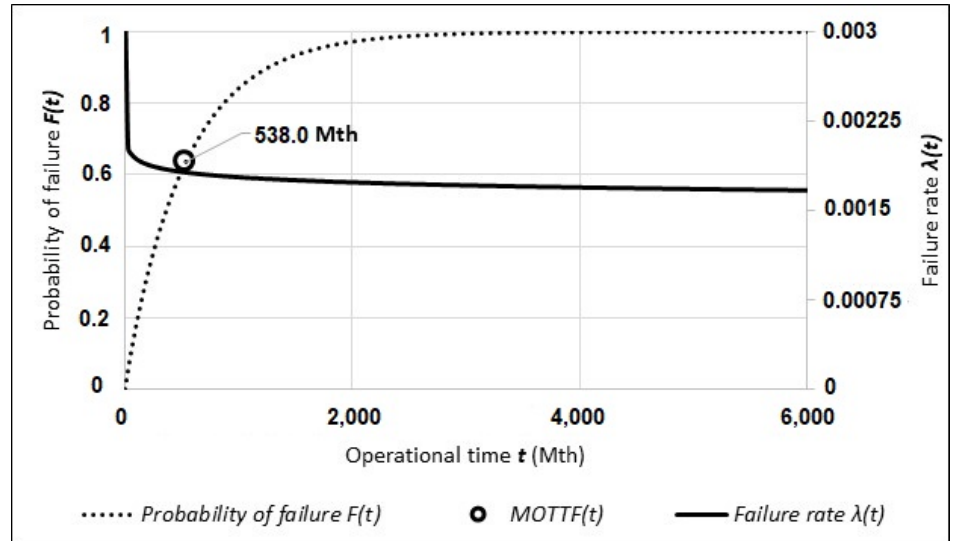
Figure 6 Failure rate λ (t) for the forwarder f810D-1110. Figure 6. Failure rate λ (t) for the forwarder f810D-1110.